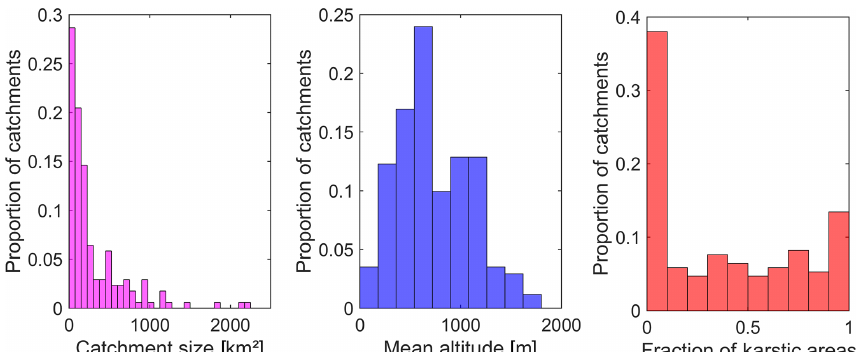
Figure 1. Catchment size, mean altitude and fraction of karstic